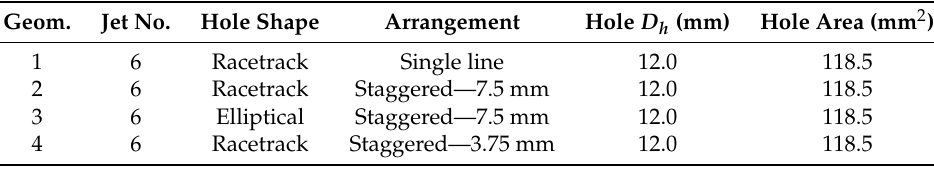
Table 3. Impingement geometry details.